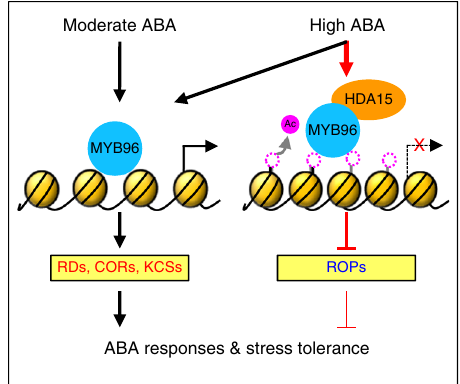
Table 1. The comparative C T method was used to determine the relative gene expression with the expression of the EUKARYOTIC TRANSLATION INITIATION FACTOR 4A1 ( eIF4A ) gene (At3g13920) as an internal control. All RT-qPCR reactions were performed using three independent replicate samples. The speci fi city of RT-qPCR results was determined by melt curve analysis of the ampli fi ed products using the standard method. Y2H assays . For Y2H assays, the expression vectors and yeast strains used were supplied by the BD Matchmaker system (Clontech, Mountain View, CA, USA). The yeast strain AH109 harboring the LacZ and His reporter genes was used. PCR products were subcloned into the pGBKT7 (for GAL4 BD fusion) and pGADT7 (for GAL4 AD fusion) vectors. The recombinant constructs were cotransformed into AH109 cells, and the transformed cells were grown on SD/-Leu/-Trp medium and SD/-Leu/-Trp/-His/-Ade medium. The interaction strength was quanti fi ed by measuring β -galactosidase ( β -Gal) activity using o -nitrophenyl- β - D -galactopyr- anoside (ONPG) as a substrate. BiFC assays . The full-size MYB96 and HDA15 coding sequence were fused in- frame to the 5 ’ end of a gene sequence encoding the C-terminal half of EYFP in the pSATN-cEYFP-C1 vector (E3082) or the N-terminal half of EYFP in the pSATN- nEYFP-C1 vector (E3081) 78 . The IDD14-RFP construct was used as a nucleus localization marker 79 . The recombinant constructs were co-transfected into Ara- bidopsis mesophyll protoplasts by the PEG-calcium transfection method. Trans- formed protoplasts were incubated at 23 °C for 12 – 16 h in darkness. Emitted fl uorescence was monitored by Zeiss LSM510 confocal microscope (Carl Zeiss, Jena, Germany). ChIP assays . Harvested plant materials were cross-linked with 1% formaldehyde, ground in liquid nitrogen, and solubilized in NLB buffer (50 mM HEPES, pH 7.5,